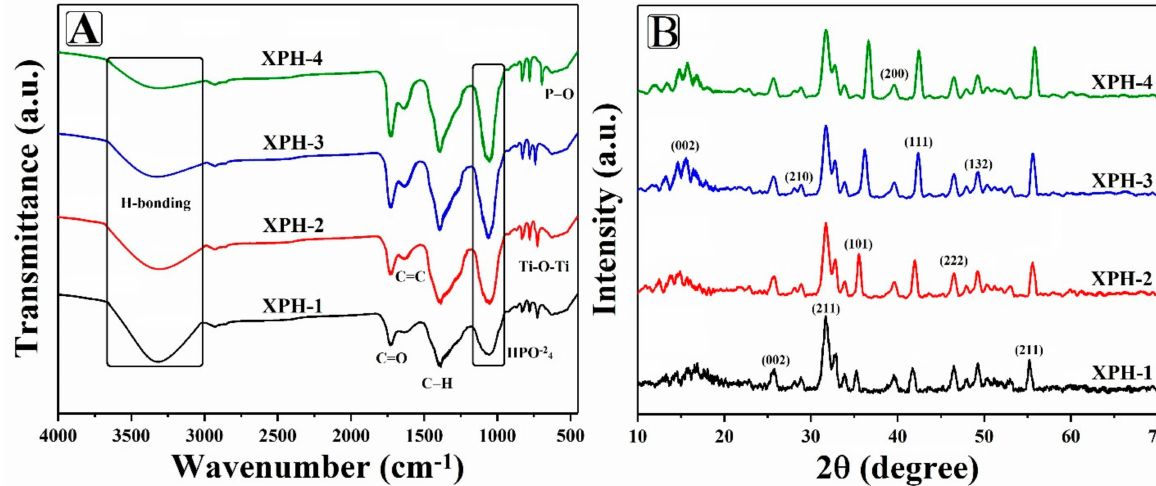
Figure 2. The spectroscopic analysis to determine structural properties of hybrid nanocomposite scaffolds. ( A ) FTIR spectral profiles to analyze the functional groups. ( B ) Diffraction spectra to investigate crystalline and amorphous behavior of the hybrid nanocomposite